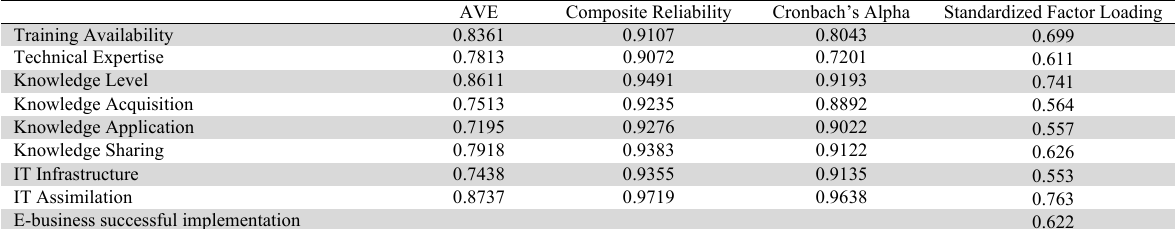
Measurement model